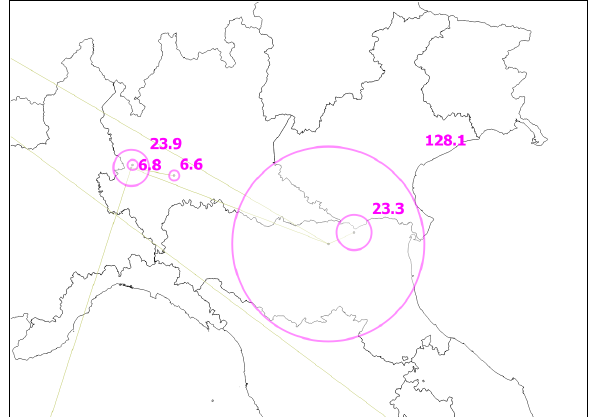
Figure 9. Enlarged portion of figure 7